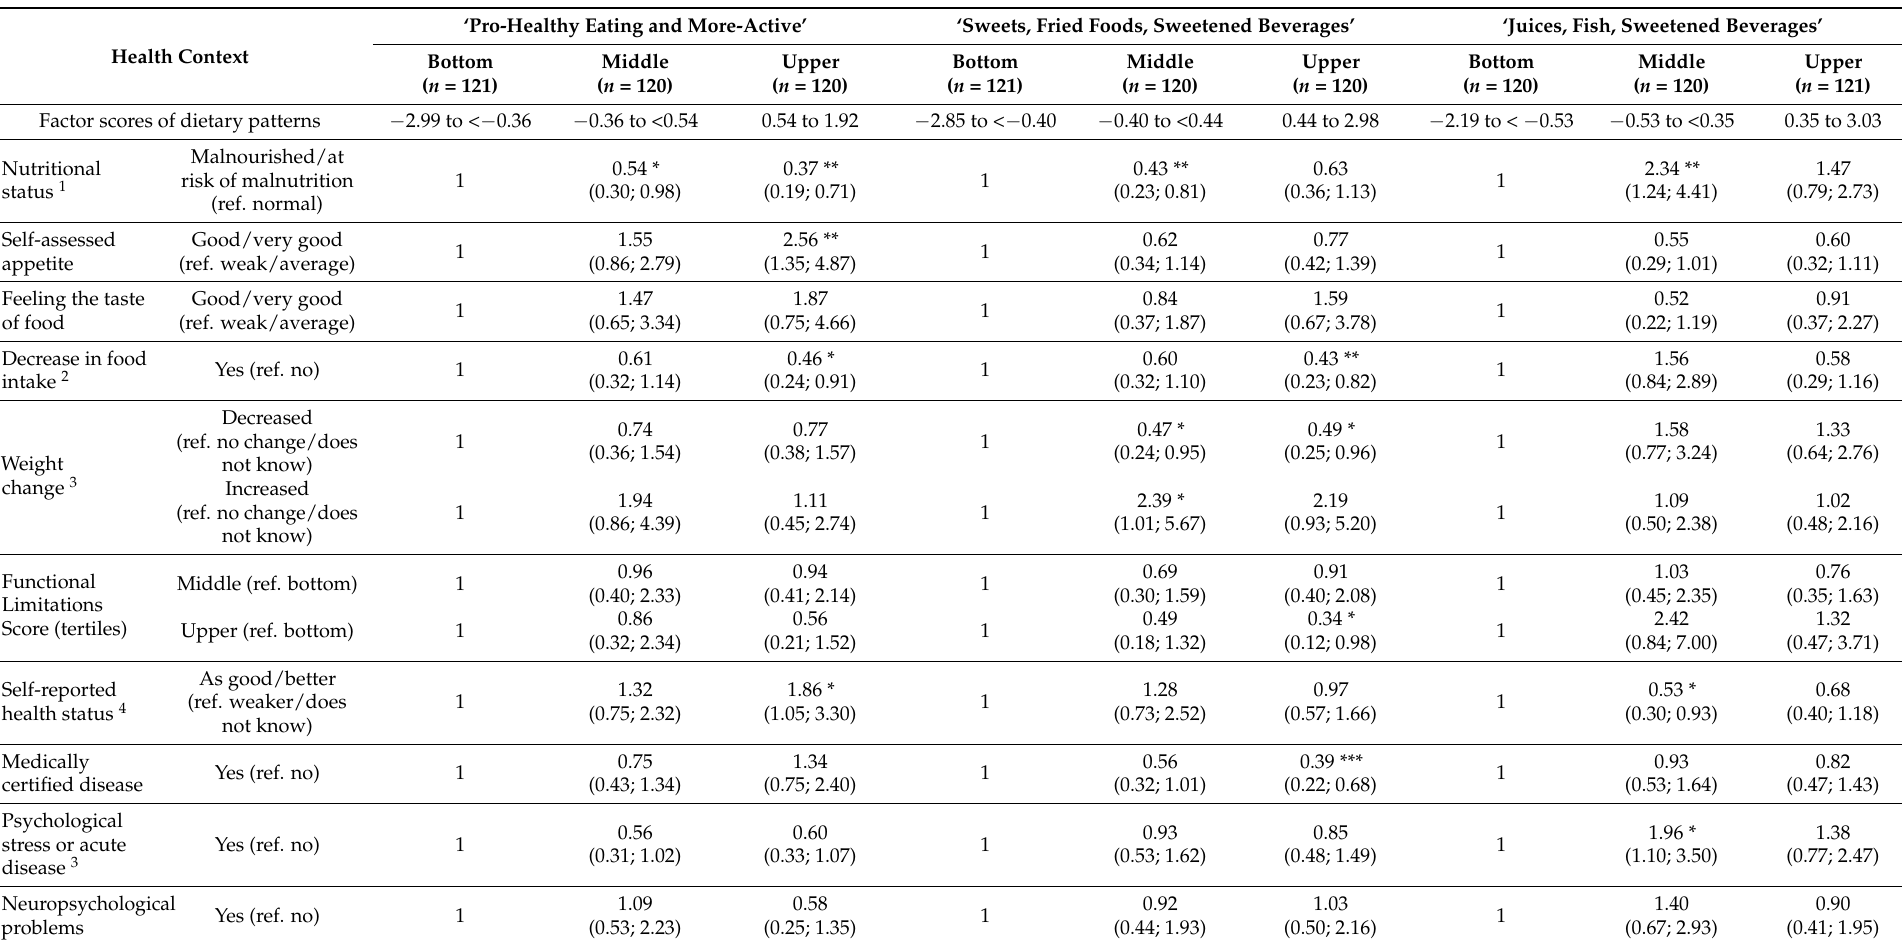
Table 6. Odds ratios (ORs with 95% confidence interval (95% CI)) of dietary–physical activity patterns (D-PAPs) according to health-condition outcomes in older Polish adults ( n =